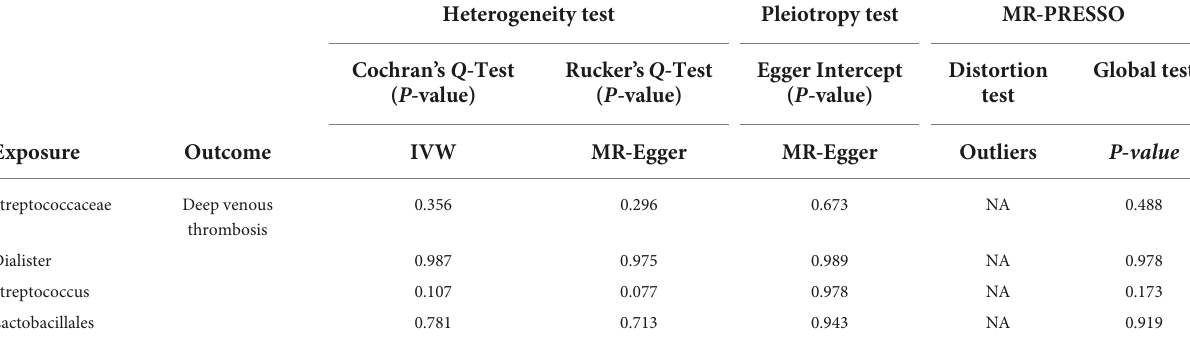
TABLE 2 Sensitivity analysis of the MR analysis results of gut microbiota and deep venous